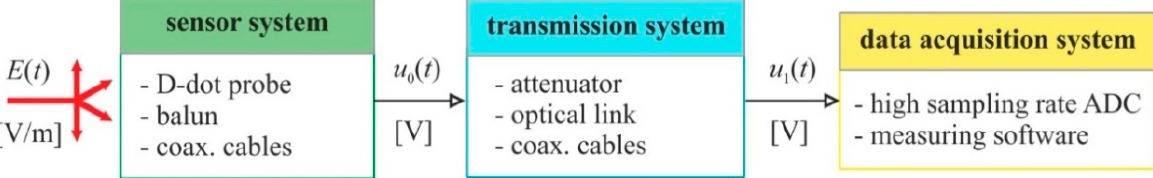
Figure 1. Structure of a high-power microwave (HPM) pulse meter.